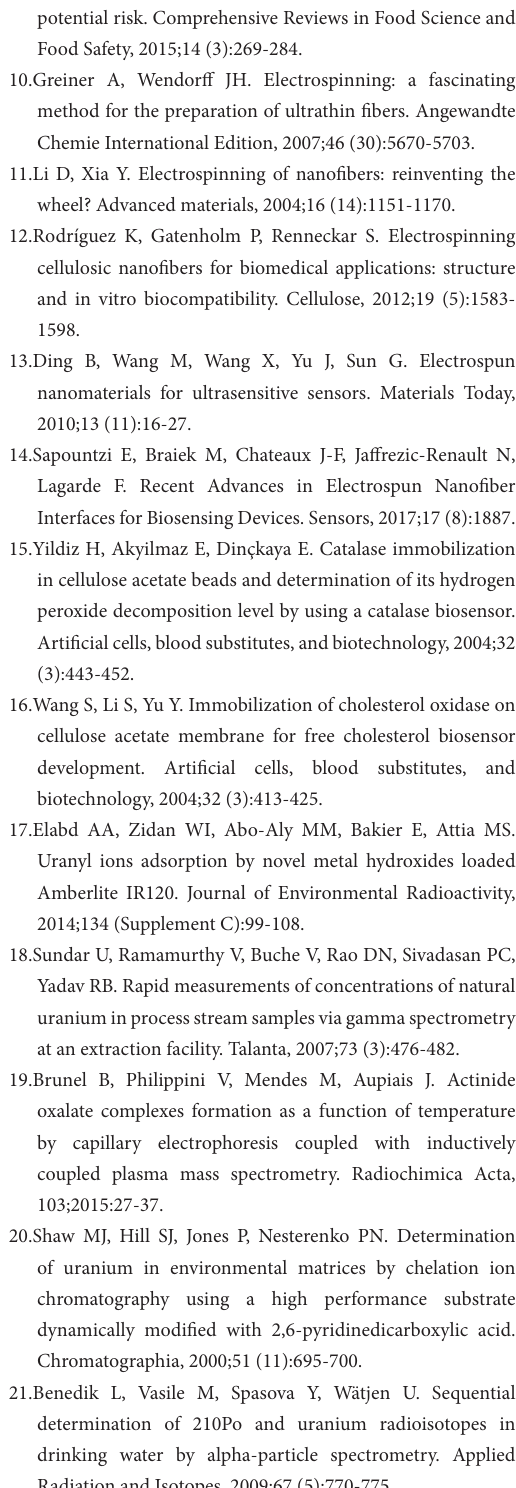
222 Nanomed Res J 2(4): 216-223,